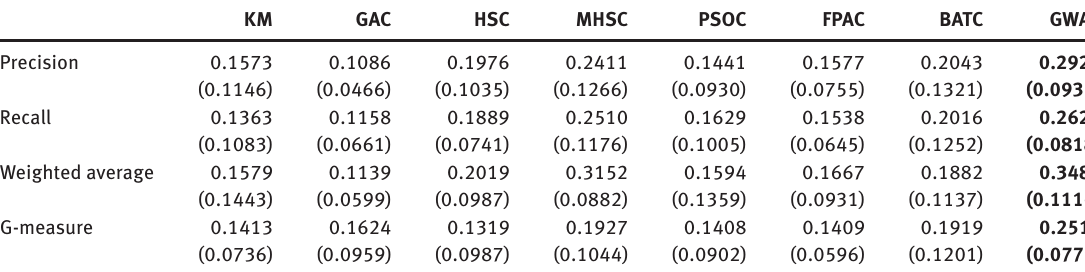
Table 7: Mean (SD) of Cluster Quality Matrices for Glass Data Set.